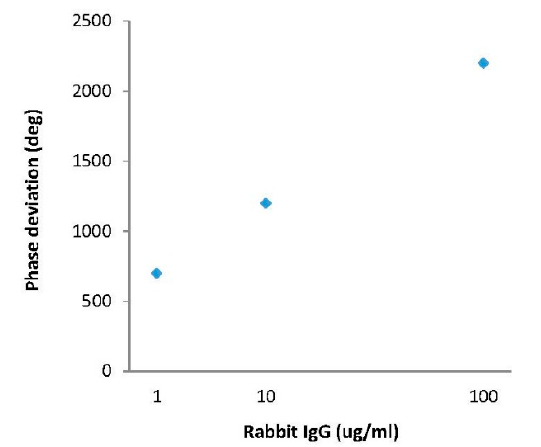
Figure 12. Phase shifts in terms of rabbit IgG